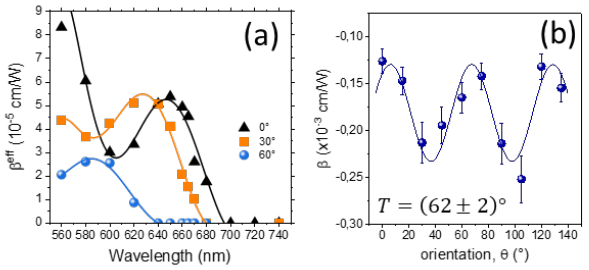
Fig. 3. (a) Spectral trend of the nonlinear absorption coefficient (β) of an Au/Al 2 O 3 MHM measured at different incidence angles for TE polarization. (b) β as a function of the input linear polarization orientation of an Au